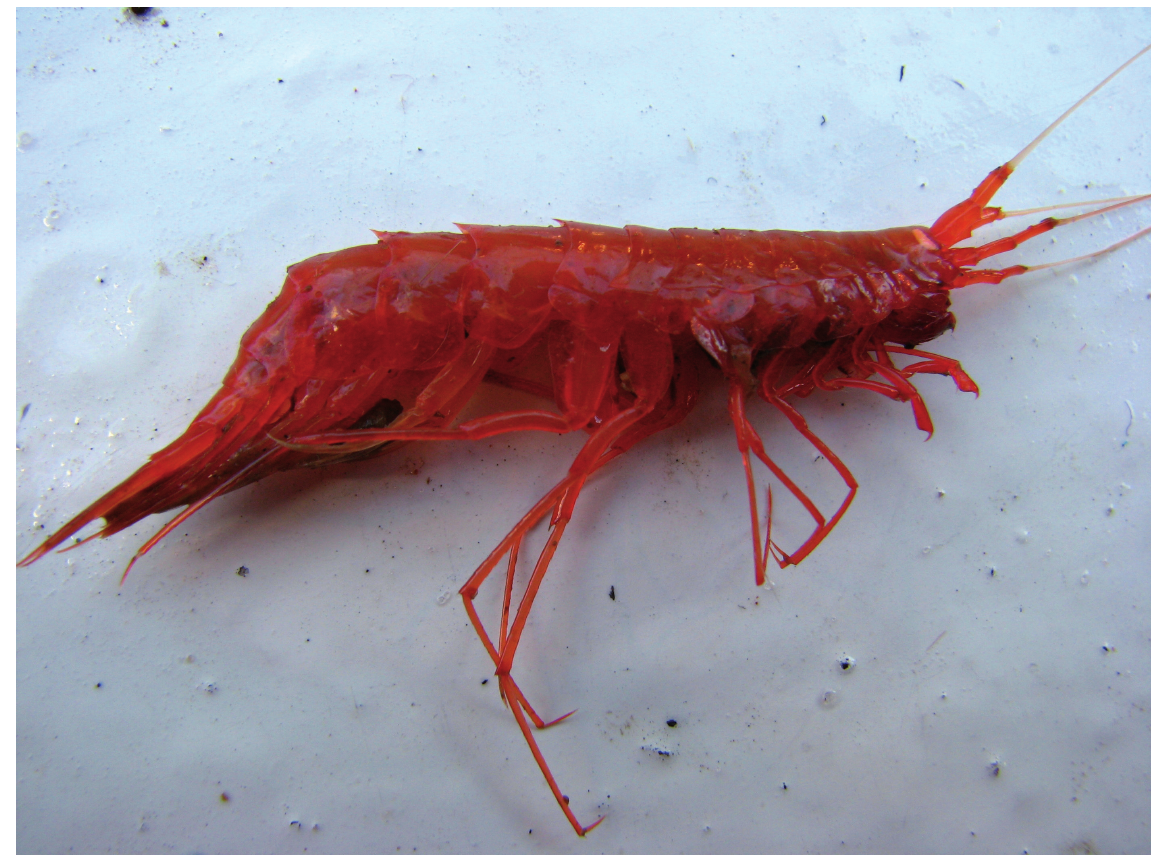
Fig. 1. Halirages cainae sp. nov., paratype, sex unknown, about 40 mm, MAREANO 2009-111, R-station 488, sample 379,